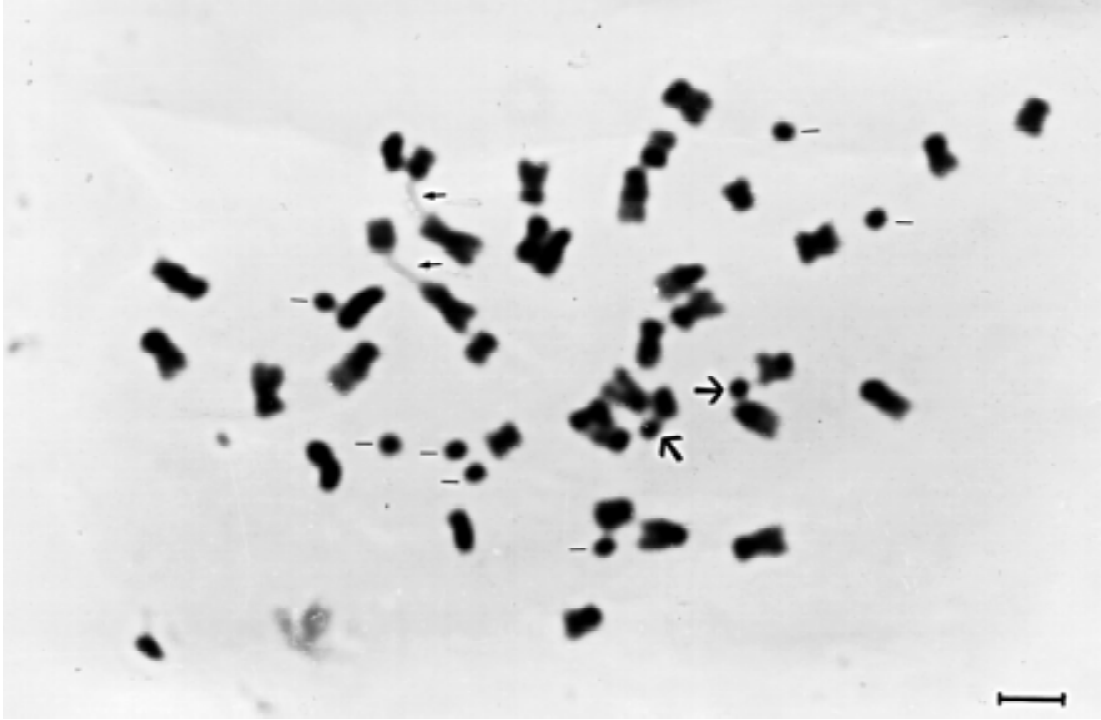
Figure 2 - Metaphase cell of Mikania cordifolia . Larger arrows indicate the positions of satellites in the tenth pair; smaller arrows indicate secondary constrictions and lines indicate B-chromosomes (in this case there are seven B-chromosomes). Bar represents 2 m